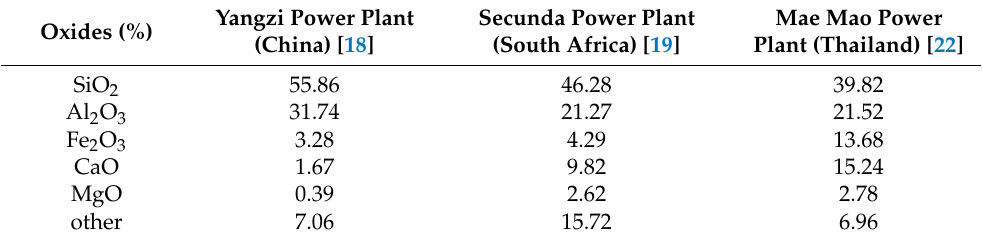
Table 1. Chemical compositions of some FA, deriving from international power plants, used in cement-based applications.